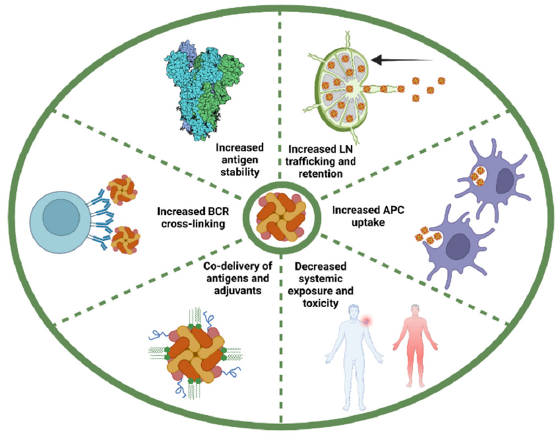
Figure 4. Key advantages of conjugating antigenic determinants on nanoparticle for protein subunit vaccines. Nanoparticle-associated antigens diffuse more efficiently to the draining lymph node (LN)